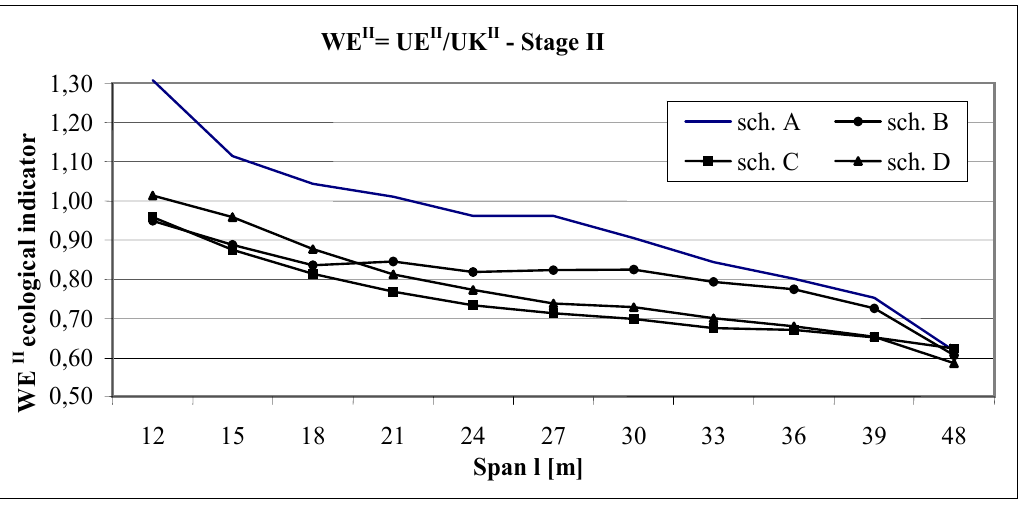
Figure 9. KJ II unit cost of creating the UK II structure per 1 m 2 of the built-up area [EURO/m 2 ].